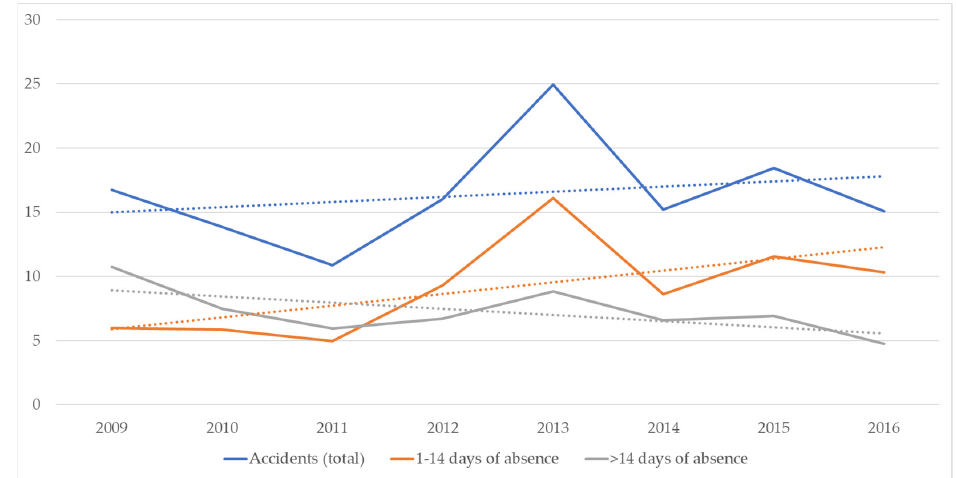
Figure 9. Incidence rates in construction of utility projects for fluids/construction of utility projects for electricity and telecommunications. Based on data from [17 – 24,27] .